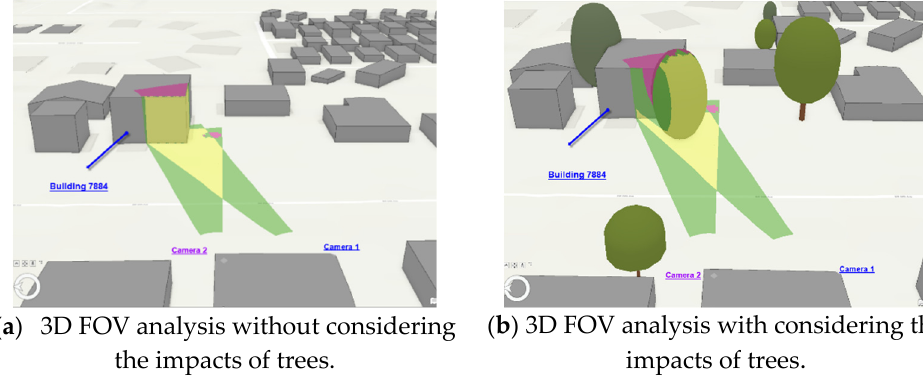
Figure 21. The visibility analysis by adding the impact of trees into consideration. ( a ) Without considering the impacts of trees. ( b ) With considering the impacts of trees .